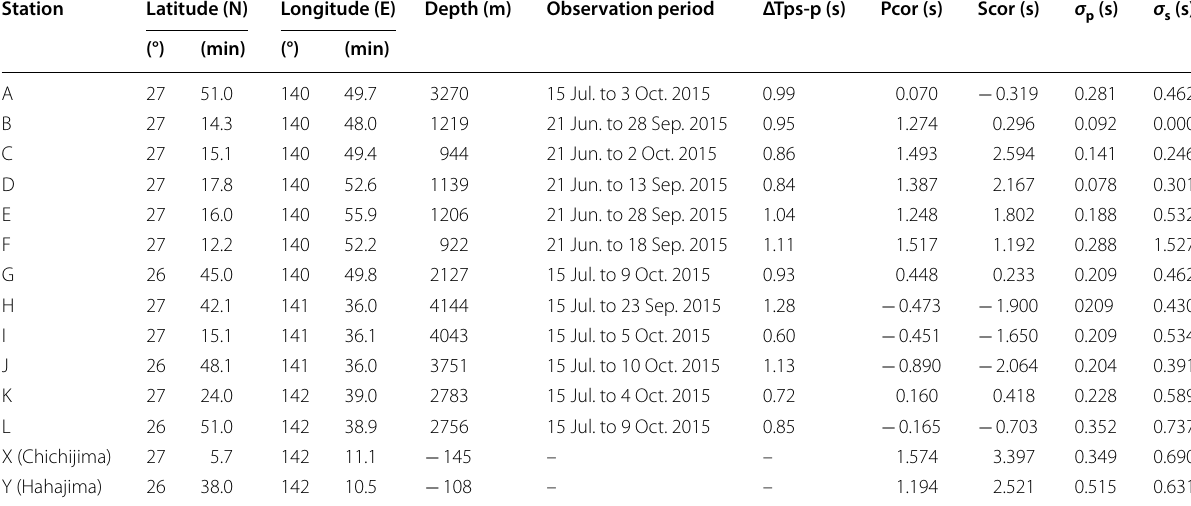
ΔTps-p, arrival-time difference between the PS and P phases; Pcor, final station correction for the P phase; Scor, final station correction for the S phase; σ p , standard deviation of the P-phase arrival time; σ s , standard deviation of the S-phase arrival time